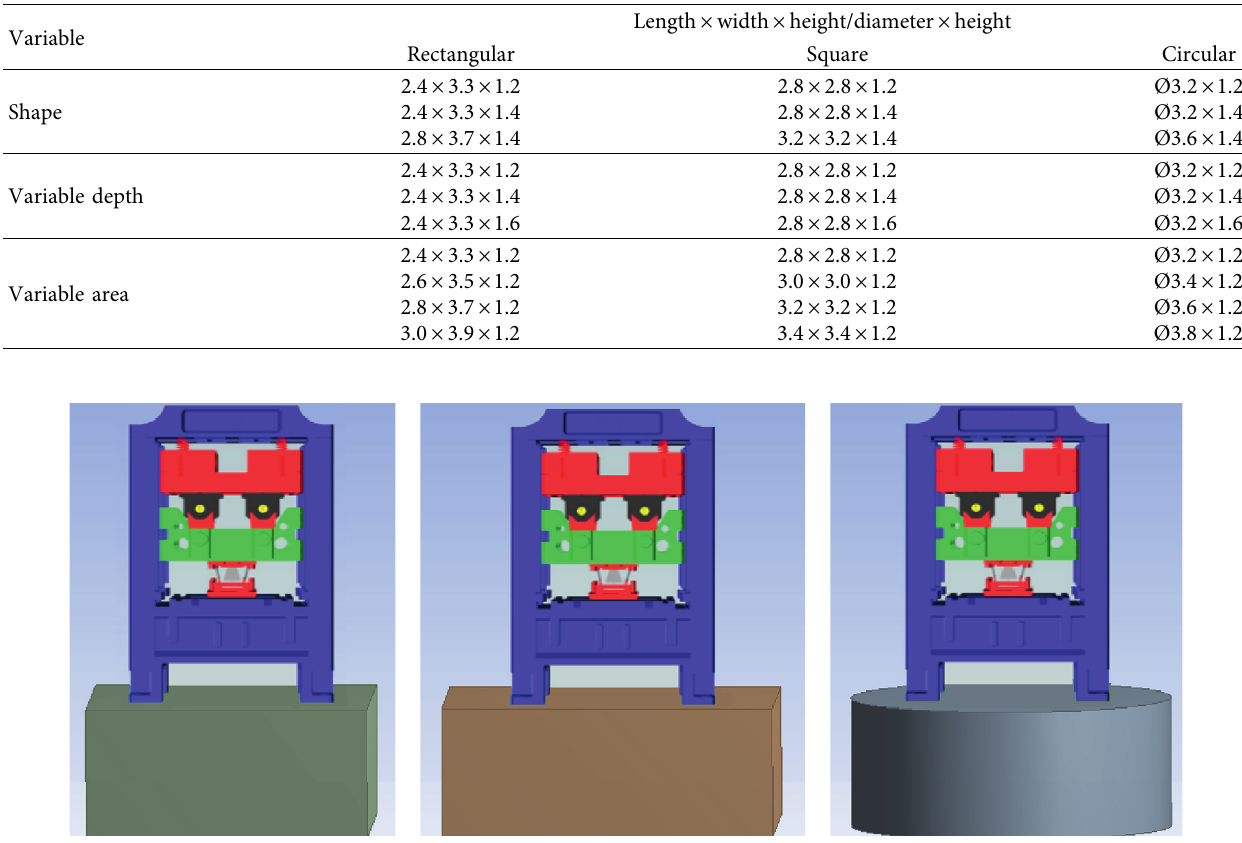
Figure 10: Crankshaft speed curve under the motor speed of 1000rpm: (a) experimental crankshaft speed curve; (b) simulated crankshaft speed curve. Table 1: Shape and dimension design of foundation (unit: m).